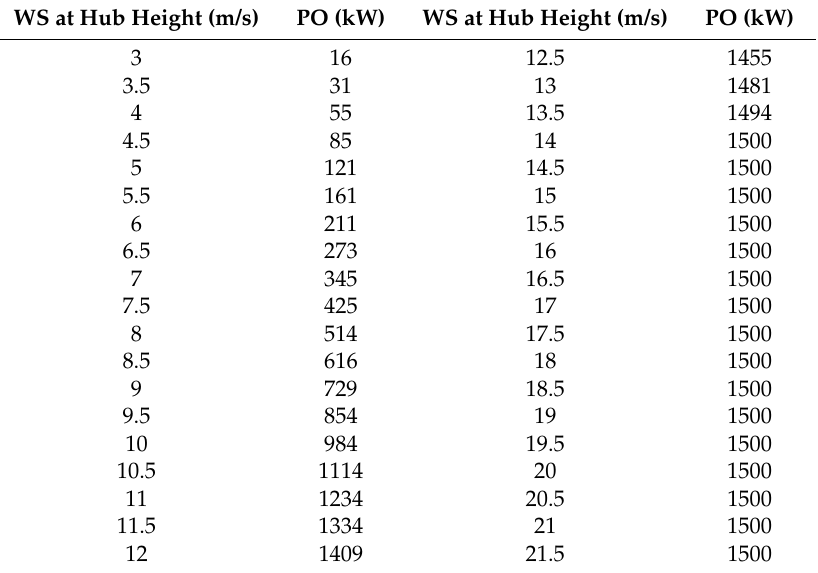
Table 1. Guaranteed power curve for the wind speed interval r 3 m { s,21.5 m { s s . WS: Wind Speed. PO: Power